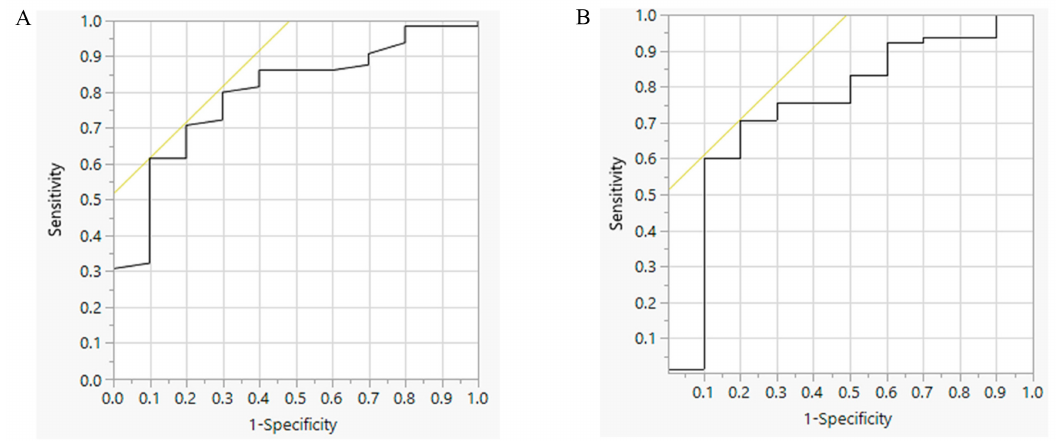
Figure 3. Performance of the SSQ score to predict 24-h urine sodium excretion ≥ 100 mmol / day using receiving operating characteristic (ROC) analysis. Panel ( A ) shows ROC curve with the SSQ score alone (AUC 0.79, p < 0.01) and Panel ( B ) shows the ROC curve for BMI alone (AUC 0.75, p =